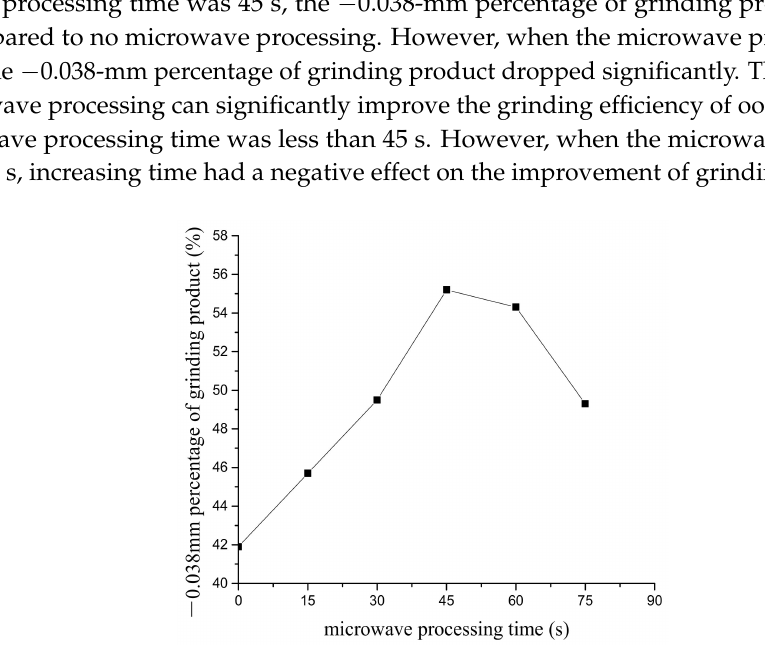
Figure 4. The − 0.038-mm percentage of the grinding product at a microwave power of 2.5 kW for different microwave processing time.